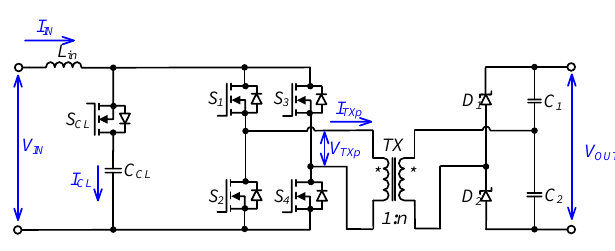
Fig. 2. Galvanically isolated full-bridge boost DC-DC converter.